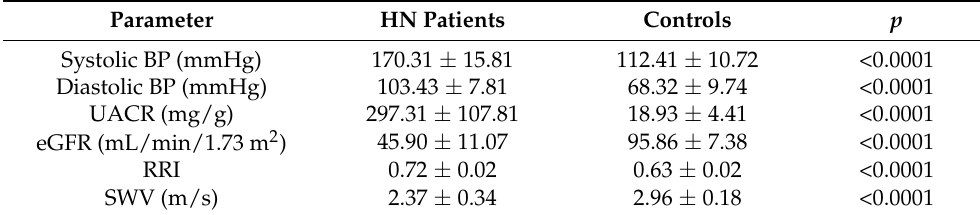
Table 2. Parameters assessed in HN patients and controls.